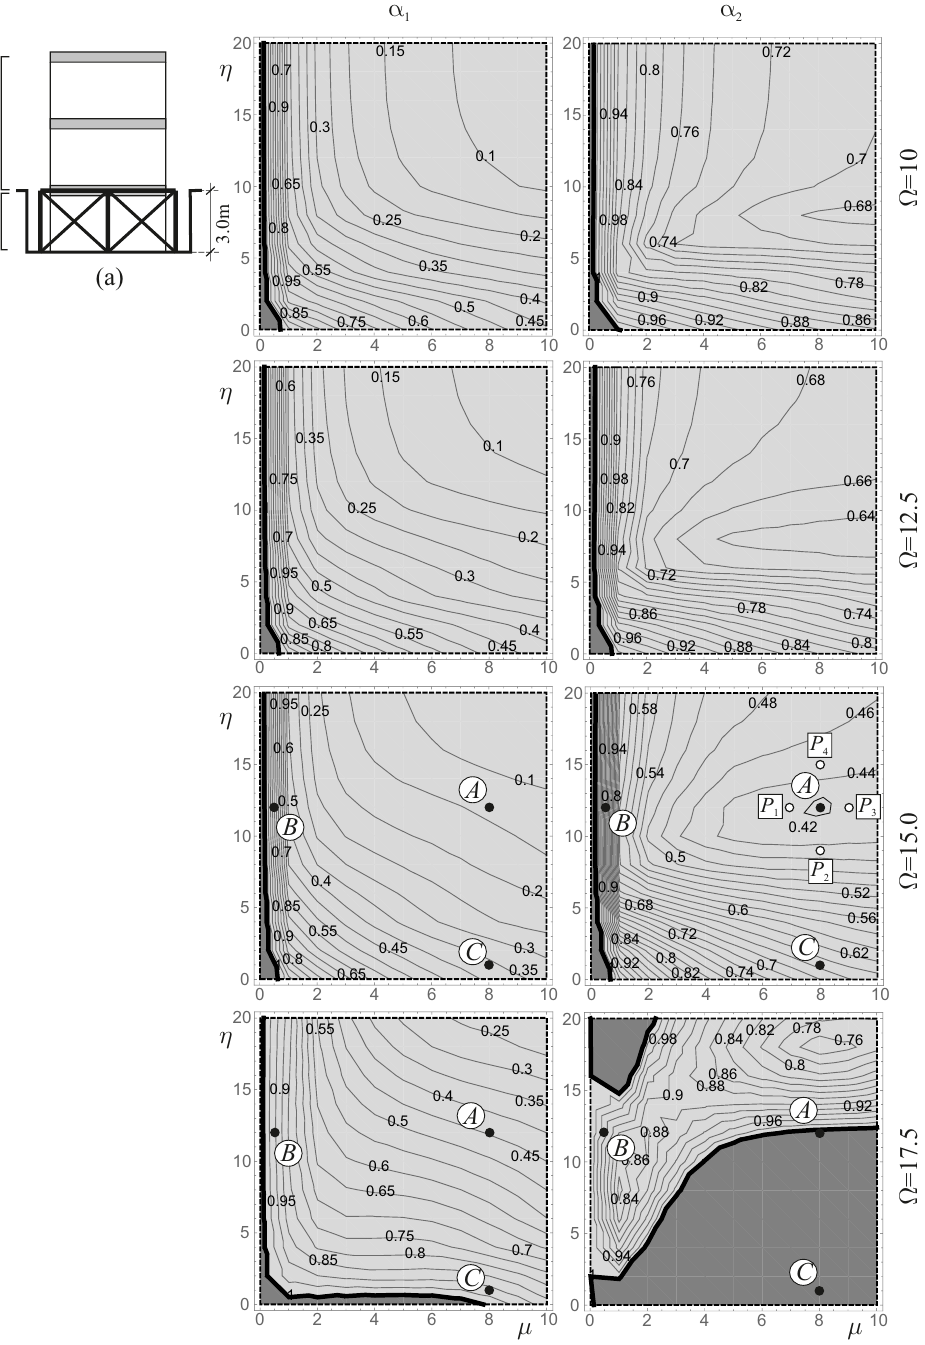
2 ); Points A – D and P s = 0.7 g m/s 1 – P 4 denote